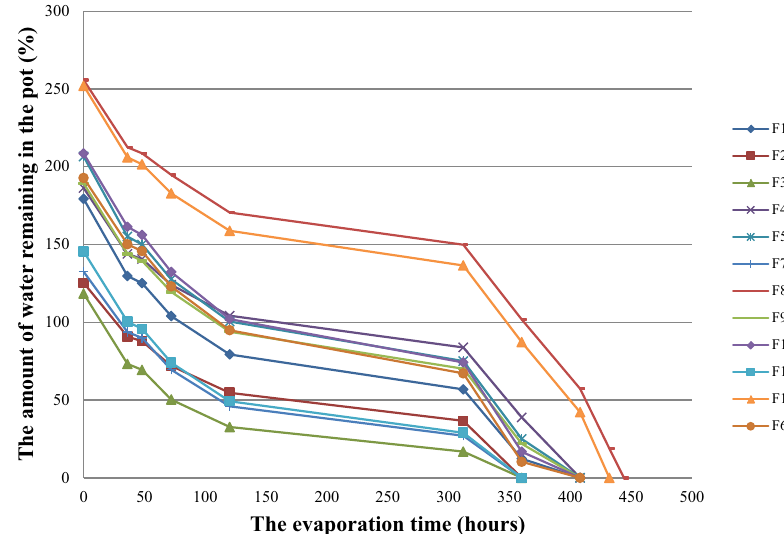
Fig. 5 Evaporation test